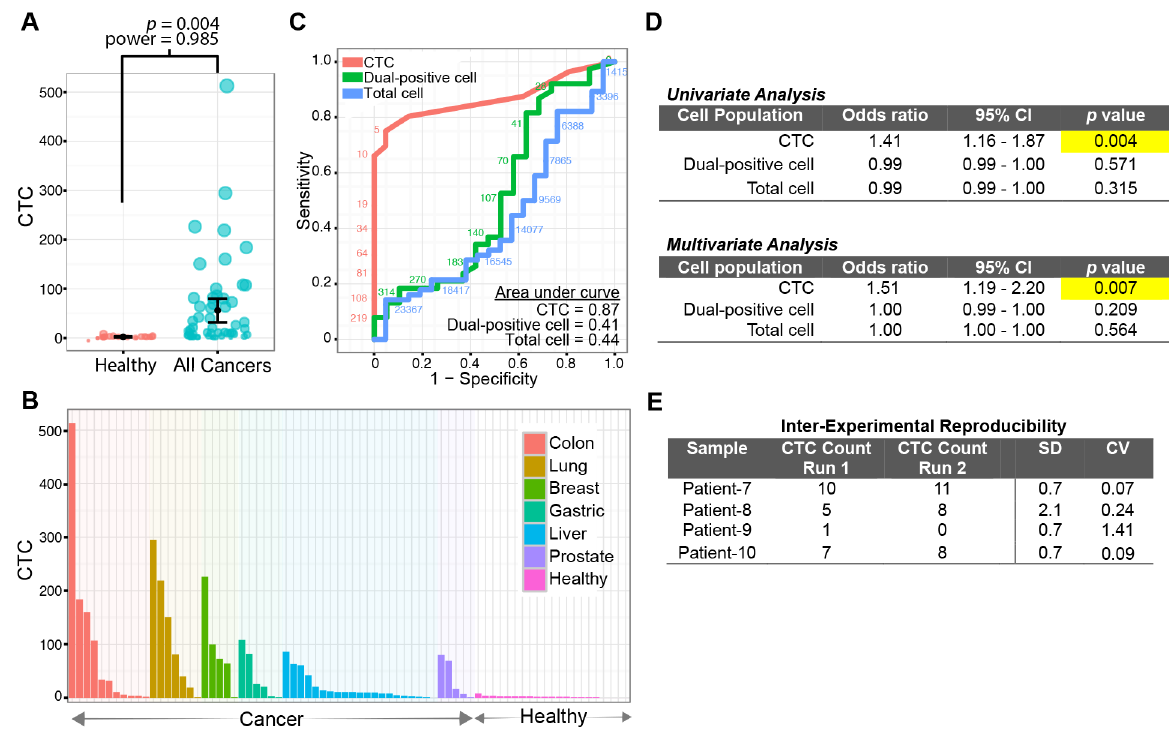
Fig 3. Validation analysis for the CTC enumeration pipeline. (A) CTC counts are significantly higherin cancer patients (n = 56) than those in healthy individuals (n = 21), p = 0.004. (B) A bar chart displayingindividualCTC counts for each cancer patient and healthy donor. (C) Receiver operatingcharacteristic (ROC) plot exhibitingthe power of CTC counts in differentiatingsamples from cancer patients and healthyindividuals.(D) Univariateand multivariateanalysestesting for the correlation of the number of CTCs, dual- positive cells, and total cells with the clinical presentation of cancer (i.e. presence of cancer). (E) Inter-experimental reproducibility of CTC assays. SD: standard deviationCV: coefficient of variation(CV).